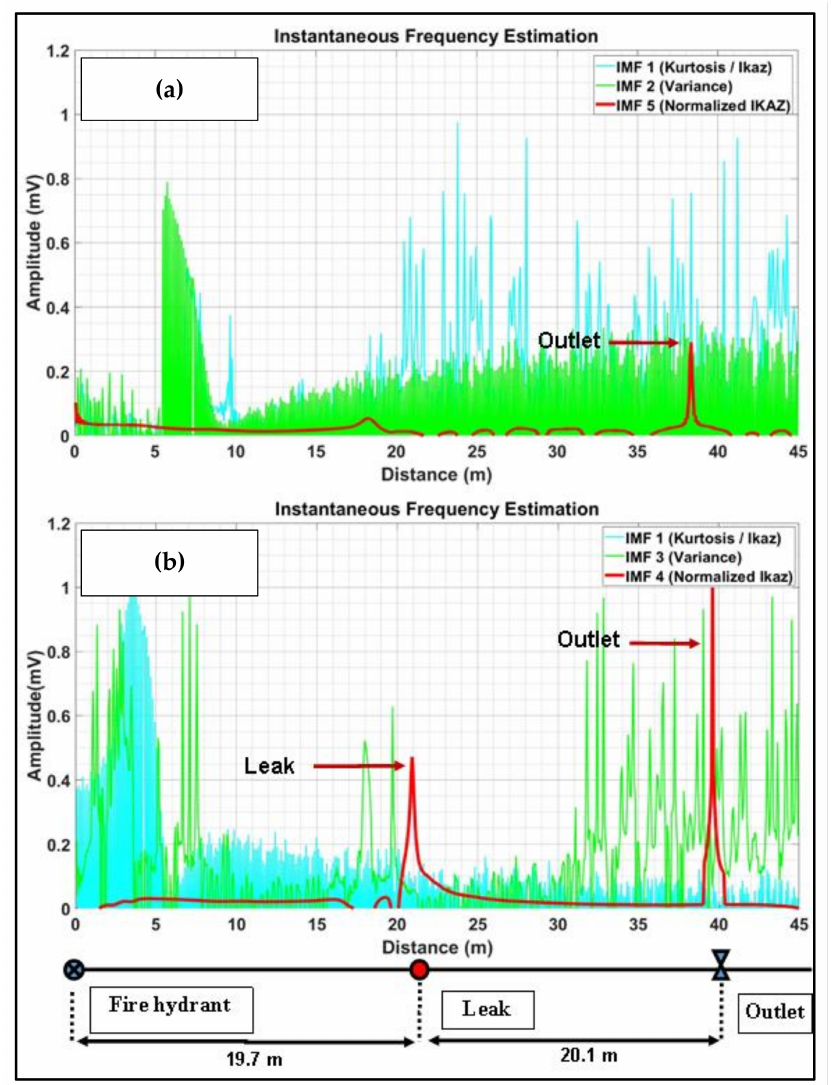
Figure 13. Hilbert Transform (HT) analysis with 2 bar for pipeline system pressure: ( a ) IMF series 5 (no-leak) ( b ) IMF series 5 (1 mm circular